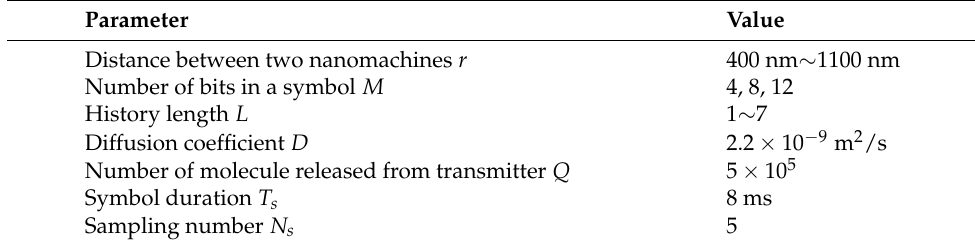
Table 1. Simulation